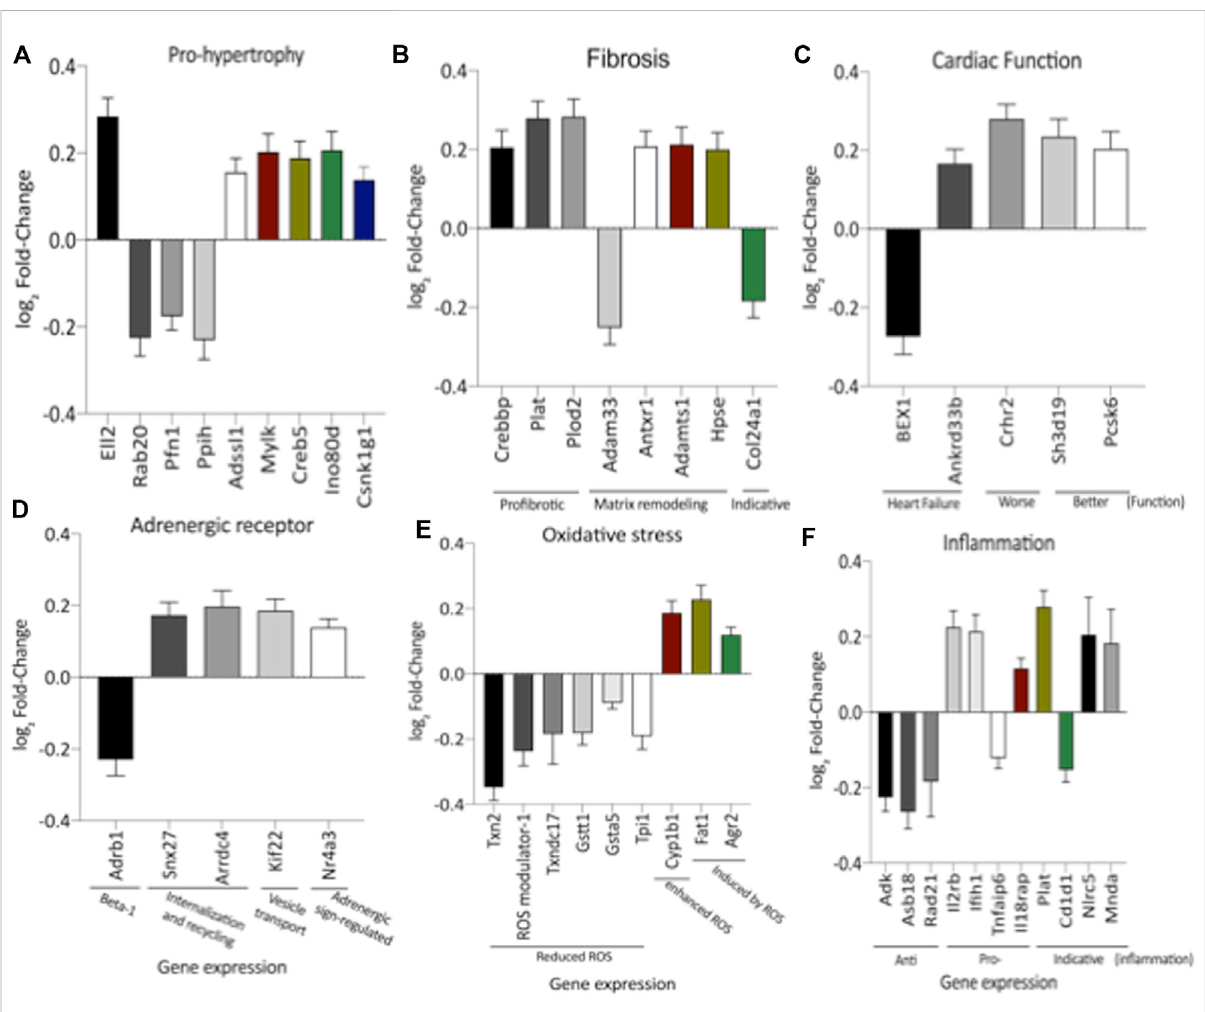
FIGURE 3 Expression of genes signi fi cantly altered, grouped by their hole in hypertrophy (A) , interstitial fi brosis (B) , cardiac function (C) , adrenergic receptorsignaling (D) ,oxidative stress (E) andin fl ammatoryactivity (F) .Thisanalysiswasperformedbasedonrelevantliteratureonaging andcardiac disease (the gene ’ s abbreviations and references are found in Supplementary Table S1). The results were expressed as mean ±